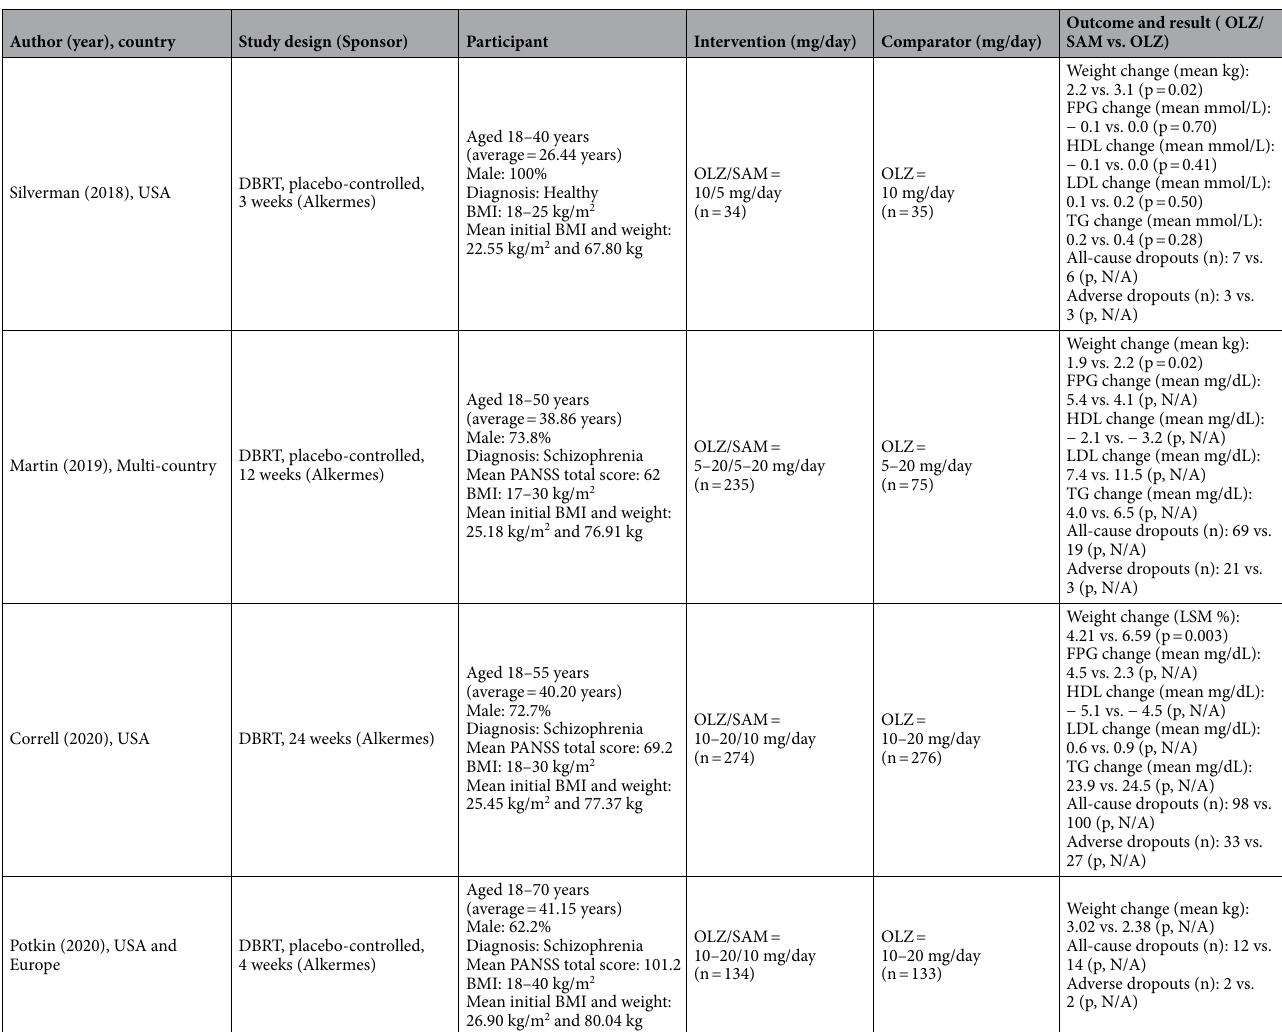
Table 1. Characteristics of randomized controlled trials comparing weight and cardiometabolic changes after short-term treatment of olanzapine/SAM and olanzapine [arranged by year of publication]. DBRT Double- blind, randomized trial, PANSS Positive and Negative Syndrome Scale, OLZ Olanzapine, SAM Samidorphan, FPG Fasting plasma glucose, HDL High-density cholesterol, LDL Low-density cholesterol, TG Triglyceride, BMI body mass index, N/A not